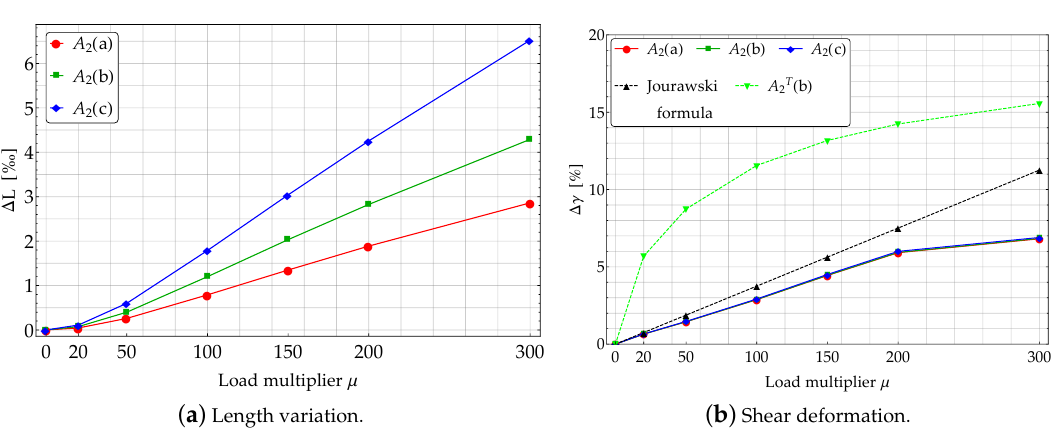
Figure 9. Effects of axial and shear deformations about study case A 2